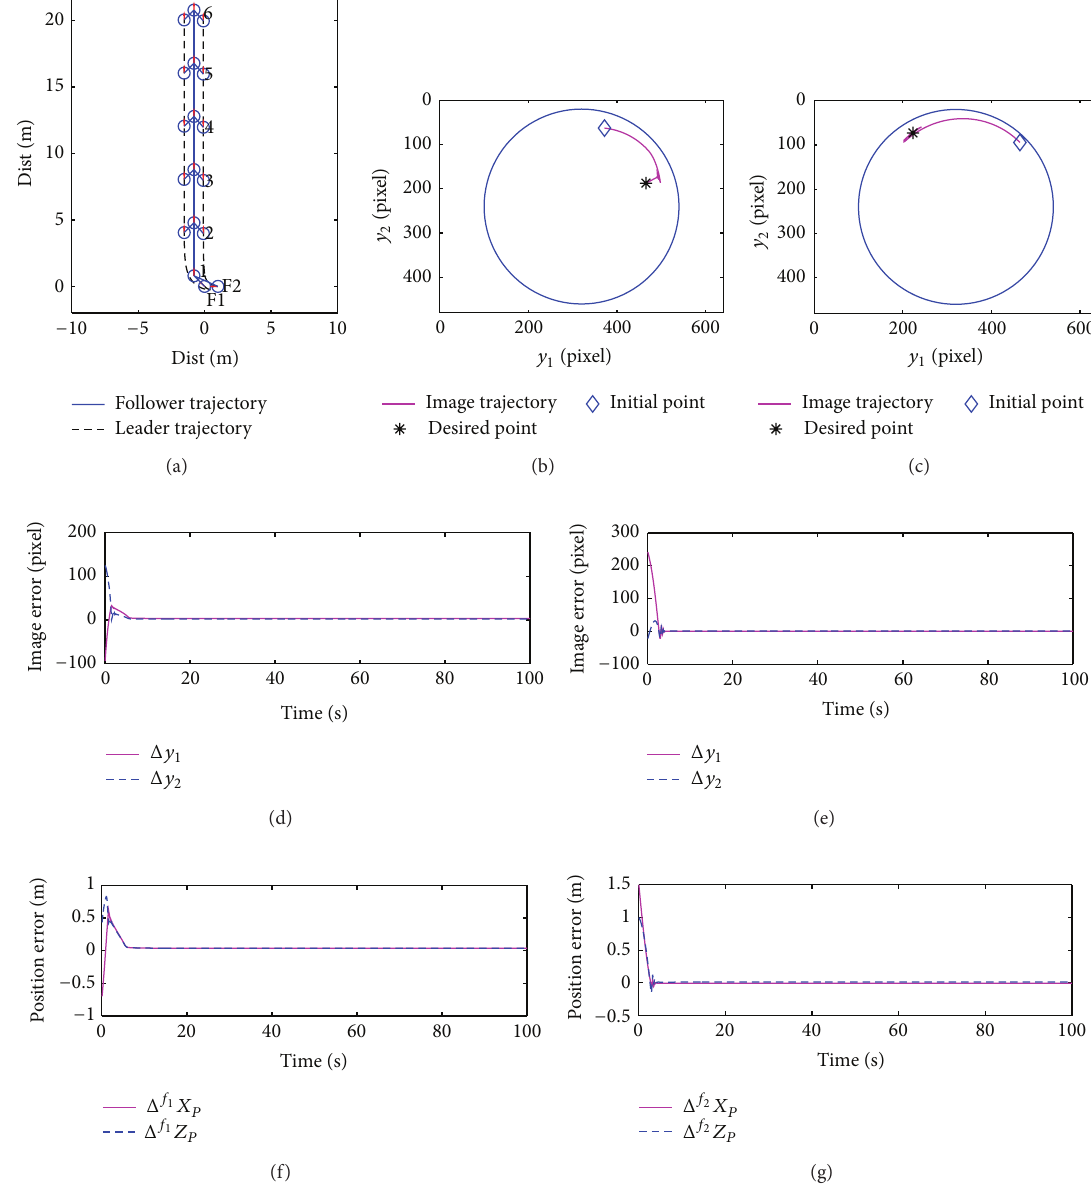
Figure 4: Line tracking results. (a) Trajectory in world frame. (b) Image trajectory of Follower1. (c) Image trajectory of Follower2. (d) Image error of Follower1. (e) Image error of Follower2. (f) Position error in frame Follower1. (g) Position error in frame